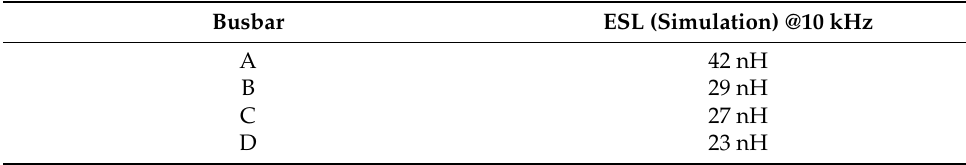
Figure 5. Busbar outline drawing. ( A ) Common shape; ( B ) adding laminated area; ( C ) three-layer composite structure; ( D ) three-layer and edge welding structure. Table 1. ESL simulation value of four